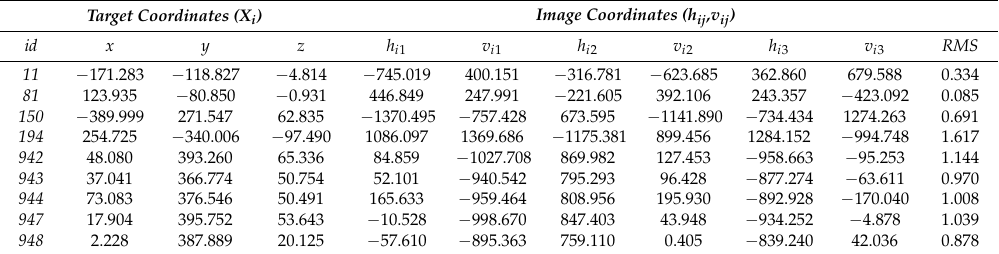
Table 3. Computed results for independent target coordinate initial approaches, given by the input data in Table 2, along with the optimization quality index for each minimized reprojection error vector (RMS in pixels). Target Coordinates (X i ) Image Coordinates (h ij ,v ij